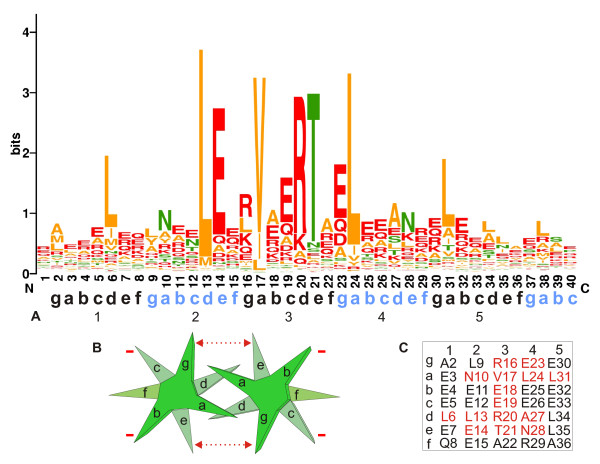
Sequence logo and interaction models for theS-helix. A) The sequence logo generated using the Weblogo program [50] is shown. The 'a' and 'd' positions of each of the 5 heptads, as per the notation of MacLachlan and Stewart [23], is also shown below the logo. B) the heptad interaction between two parallel helices is shown. The dotted red arrow indicates the 'g'-'e' interaction. The red negative sign ("-") indicates that most prevalent residues at the b and c positions are negatively charged. C) The most prevalent residue of each position on the S-Helix is shown as a table with the rows showing the positions in each heptad, and the columns showing the five heptads. The residues in red indicate the highly conserved positions.